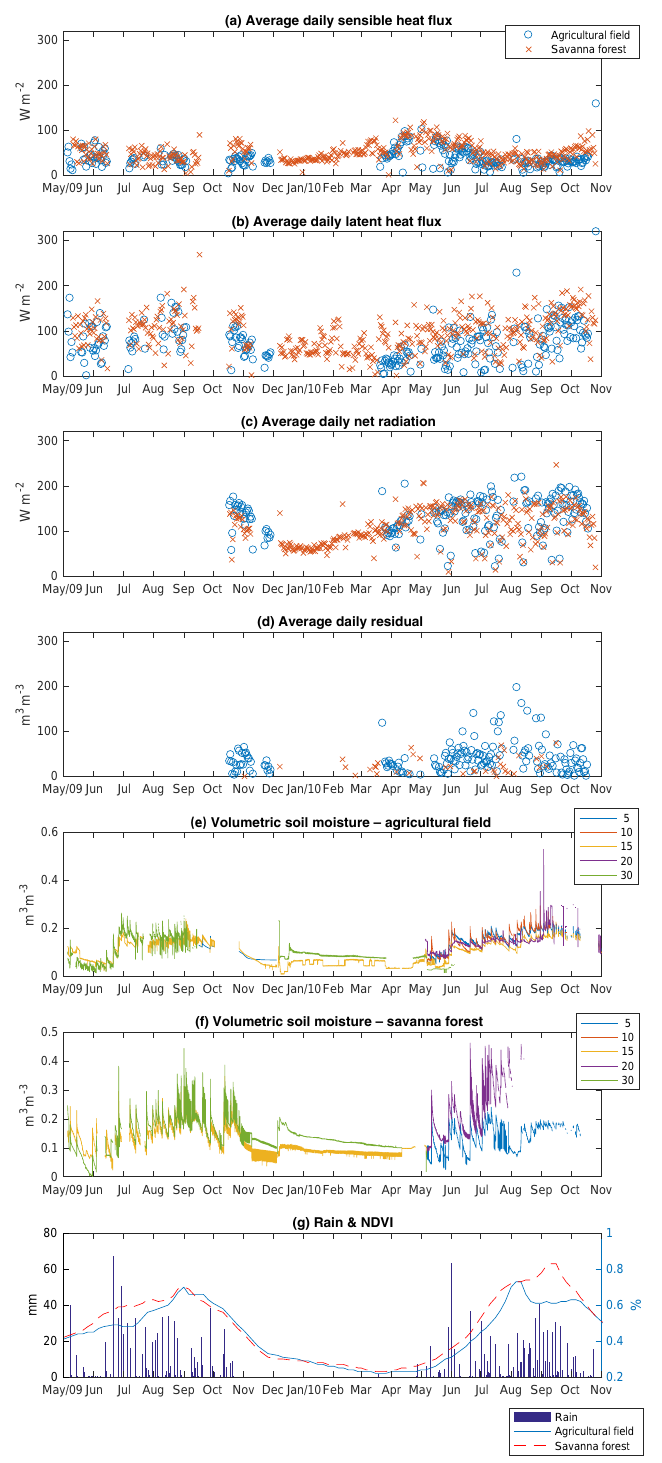
Figure 4. Time series of average daily sensible heat flux (a) , average daily latent heat flux (b) , average daily net radiation (c) , average daily residual (d) , volumetric soil moisture in the agricultural field (e) , volumetric soil moisture in the savanna forest (f) , and daily rain and NDVI (g) . Panels (a–d) show the data from the energy balance stations over the agricultural field (blue circles) and savanna forest (red crosses) in watts per square meter. Panels (e–f) show the volumetric soil moisture at five different depths over the same time period. Finally, panel (g) shows the NDVI for the pixels containing the energy balance station in the field (blue dashed) and in the savanna forest (red, solid). The daily rain in millimeters is shown as a bar